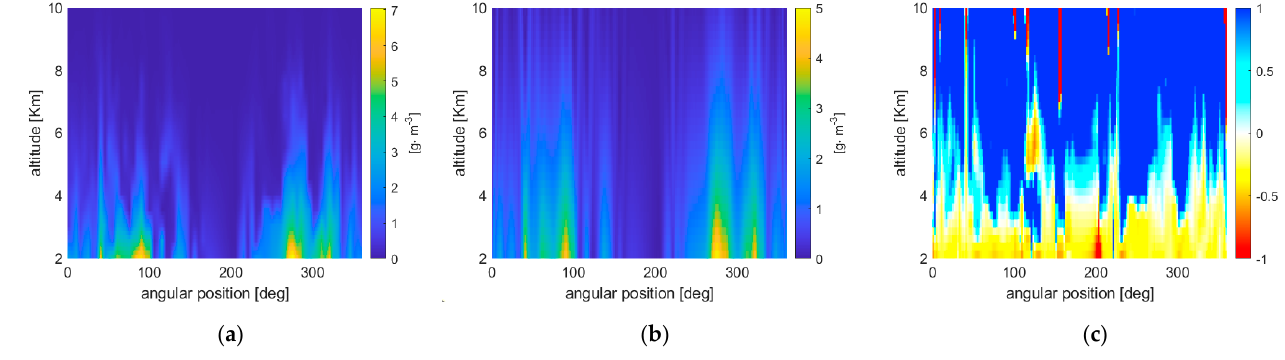
Figure 1. ( a ) True WV field (ECMWF analysis T511 L91 of 15 January 2011 taken at 20° longitude East) as a function of angle and altitude; ( b ) retrieved WV field; ( c ) normalized error field defined as in Equation (17). The angular coordinate has the origin in the North Pole and descends along the 20° East longitude meridian. Satellite configuration: 1Tx ‐ 5Rx. Figure 1b,c, respectively, show the ERTA reconstruction and the normalized error between the retrieved WV field and the original one of Figure 1a. These results refer to a constellation of 6 satellites (1Tx ‐ 5Rx). The reconstruction sampling grid has a spacing of 1° and 250 m in the angular and radial directions, respectively. For the generic position (i,j), where i and j indicate the indices of the discretized angular and radial positions, the normalized error is defined as